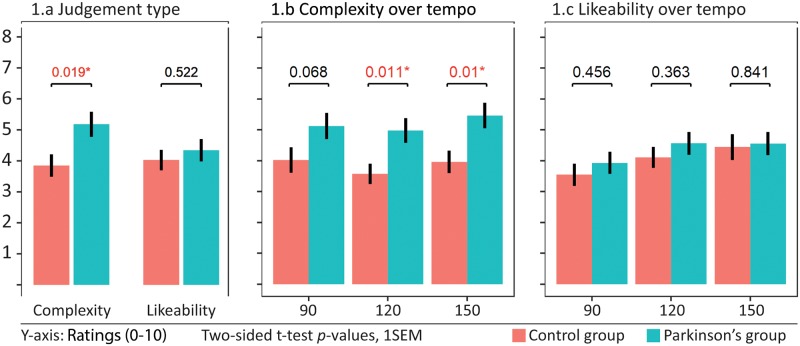
Between-groups differences for complexity and likeability ratings across all rhythms.Two-sided t-tests for between-group differences for overall complexity and likeability ratings (1.a), between-group differences for overall complexity (1.b) and likeability ratings (1.c) for three different tempi. Error bars represent 1 standard error of the mean (SEM).